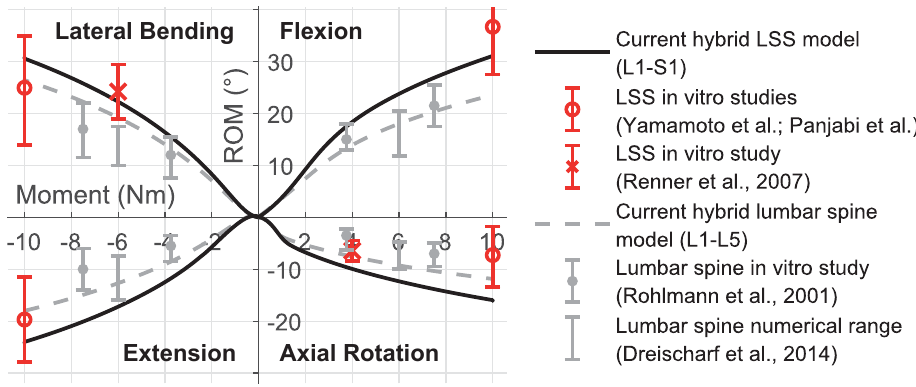
Fig 8. Nonlinear load-displacement curves of LSS (L1-S1) and lumbar spine (L1-L5) under pure moments. The predicted total ROM are compared to in vitro measurements [15, 115, 140] and the numerical range of eight published simulation models